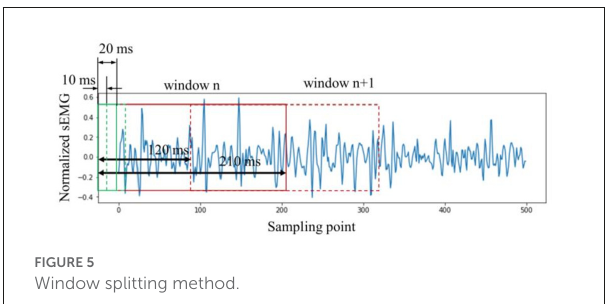
FIGURE5 Window splitting